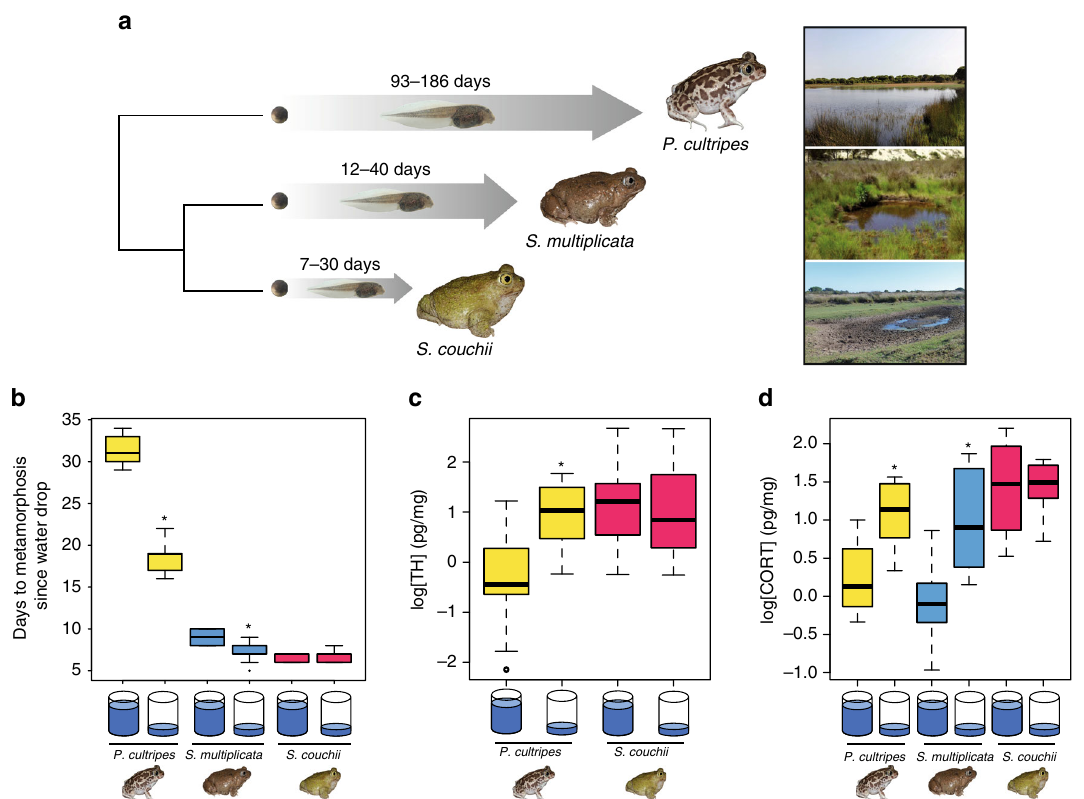
Fig. 1 Endocrine basis of species differences in larval period and plasticity. a Spadefoot toads have evolved the largest differences in development rate among anurans. Old World spadefoot toads ( Pelobates spp.) tend to breed in long lasting ponds and have a relatively longer larval period. The closely related New World species have evolved faster developmental rates, and S. couchii in particular shows the fastest developmental rate known in anurans. Phylogenetic relationships among spadefoot genera with corresponding larval period durations and a typical pond for each genus are shown. b Simulated pond drying initiated at Gosner stage 35 (early prometamorphosis) and maintained until measurement at Gosner stage 42 (metamorphic climax) induced marked developmental acceleration in P. cultripes (in yellow), an intermediate response in S. multiplicata (in blue), and no signi fi cant response in S. couchii (in red). Boxes in the boxplots indicate the median and the upper and lower quartiles, whereas the whiskers indicate the minimum and maximum values excluding outliers. Sample size was 10 for all species and treatments. c , d Developmental acceleration in P. cultripes in response to simulated pond drying is regulated by c increased thyroid hormone (TH; p = 0.00019) and d increased corticosterone (CORT; p = 0.0027). We observed a similar degree of CORT increase regulating adaptive plastic responses in S. multiplicata ( d ; p = 0.00083). However, S. couchii exhibited a higher and invariant tissue content of both hormones c , d underlying its minimal adaptive developmental plasticity. Simulated pond drying was initiated at Gosner stage 35 (early prometamorphosis), and hormone tissue contents were assessed using tadpoles at Gosner stage 38 (late prometamorphosis). Sample sizes were 7 and 9 for TH in P. cultripes in high and low water levels, and 10 for S. couchii for both treatments. Sample sizes for CORT data were 9 and 8 for high and low water levels in P. cultripes and 10 for the other species and treatment combinations. Asterisks indicate statistically signi fi cant differences between tadpoles within a species raised in